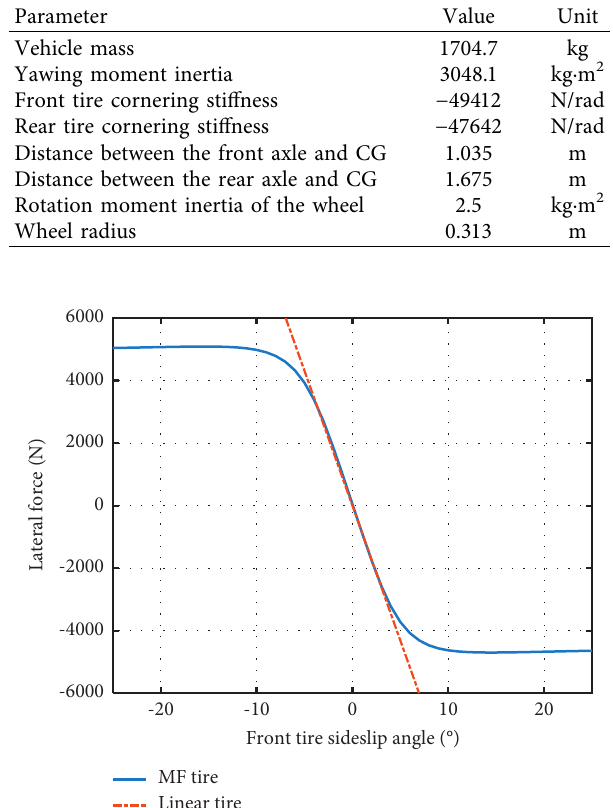
Figure 3: Comparison of lateral force of the front tire.